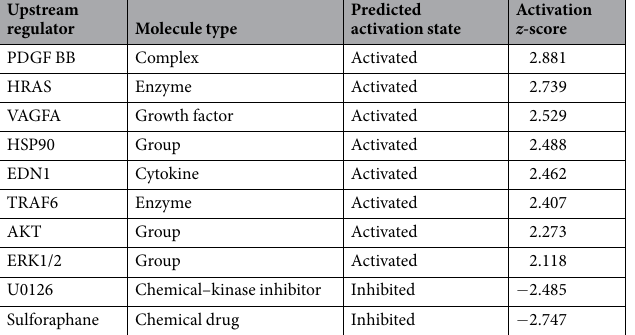
movement’, ‘molecular transport’ and ‘cellular function and maintenance’ activated in this order (Fig. 3). The cate- gory of ‘cell-to-cell signalling and interaction’ especially included a number of ‘increased ( z -score > 2.000)’. These findings predicted that exosomes released from PK-45H cells may activate several signalling molecules involved in the cell survival and mortality of HUVECs via cell-to-cell communications. Effects on signal molecules in HUVECs treated with exosomes released from PK-45H cells. Activations of PI3K/Akt and MAP kinase signalling were predicted in treated HUVECs (Table 1). Therefore, the phosphorylation status of Akt and ERK1/2 in HUVECs treated with 10 ng/ µ L exosomes was examined by Western blotting. Exosomes induced increased expressions of phospho-Akt (S473) and phosphor-ERK1/2 (Thr202/Tyr204) in HUVECs within 10 min (Fig. 4a, Supplementary Fig. S4). Phosphorylation of Akt and ERK1/2 continued at least for 12 h after treatment with 10 ng/ µ L exosomes (Fig. 4a, Supplementary Fig. S4). This indicated that exosomes released from PK-45H cells early lead to activation of PI3K/Akt and MAP kinase signal- ling pathways in HUVECs.